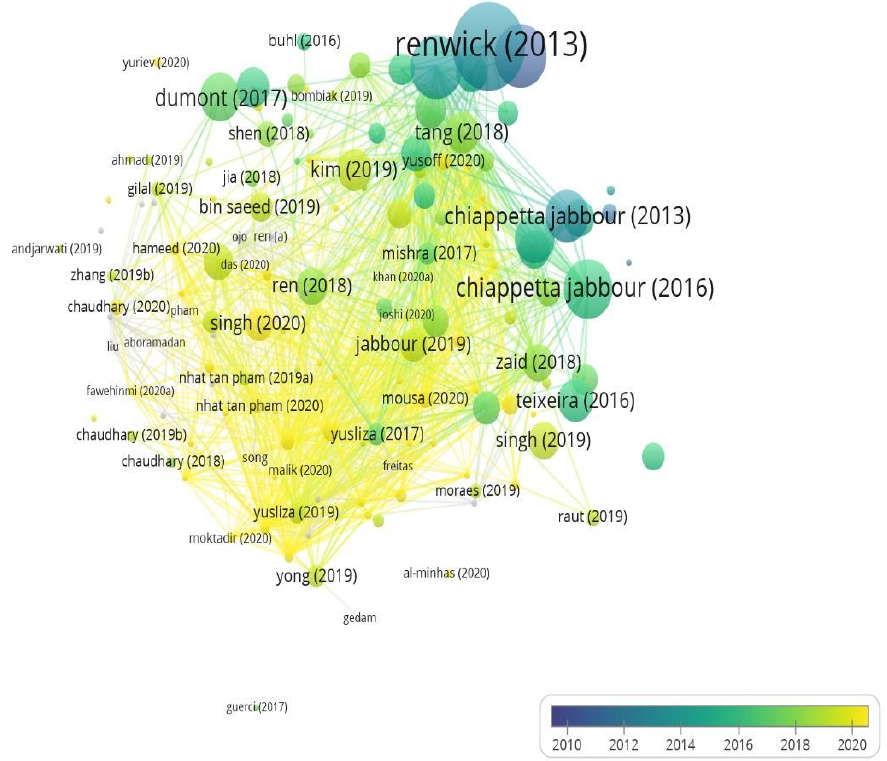
Figure 6. Bibliographic coupling with temporal analysis.